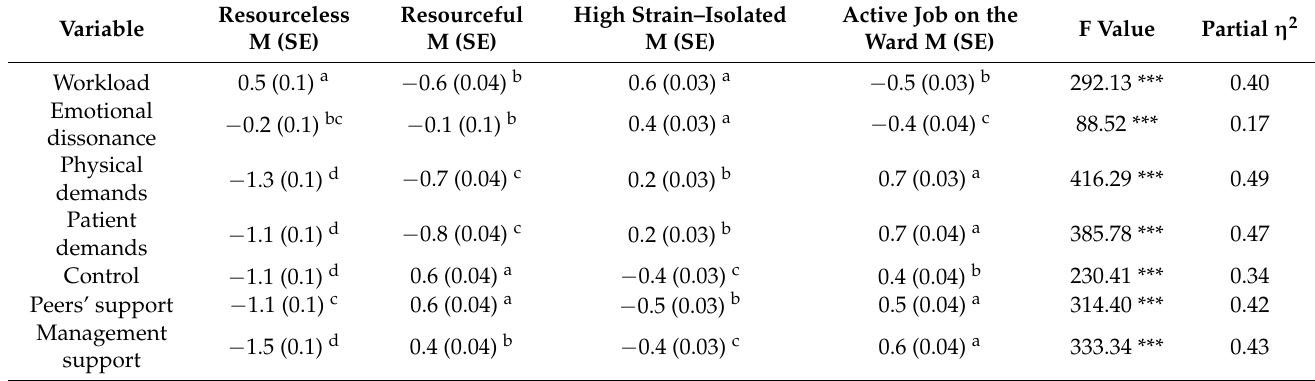
Figure 2. Latent profile of job demands and resources. Table 3. Estimated means and standard errors for job demands and resources in the four